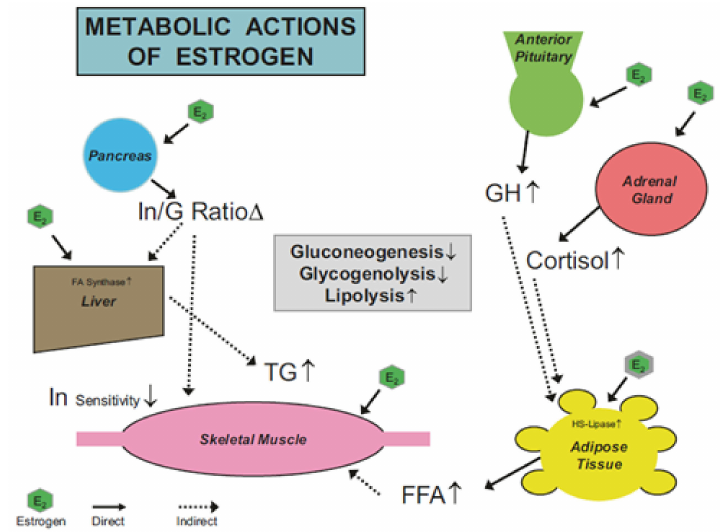
Figure 1. The figure illustrates the direct ( ____ ) and indirect (—-) effects of estrogens (E 2 ) on a variety of hormones and physiological processes important to exercise energy metabolism; e.g., energy substrate availability-mobilization, Abbreviations: FFA = free fatty acids, G = glucagon, GH = growth hormones, I insulin, TG = triglycerides. Symbols: ↑ = increase, ↓ = decrease, ∆ = change. Taken from [5], used with